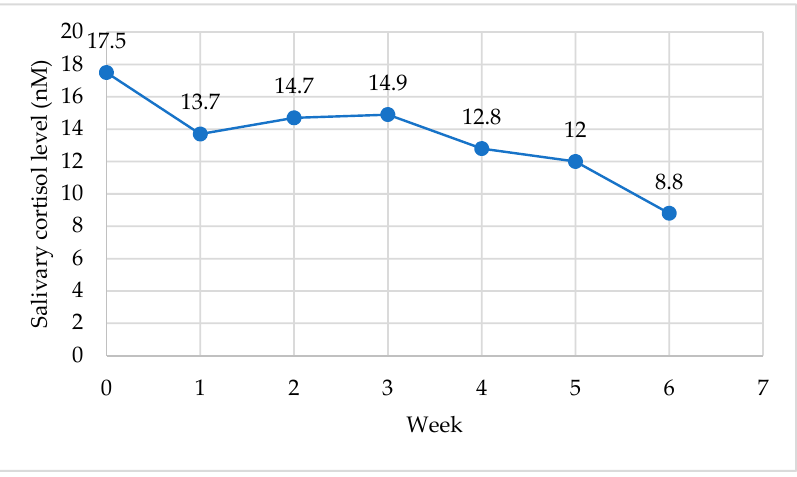
Figure 3. Waking (CAR) salivary cortisol levels from baseline to week 6 of the program ( n = 17).